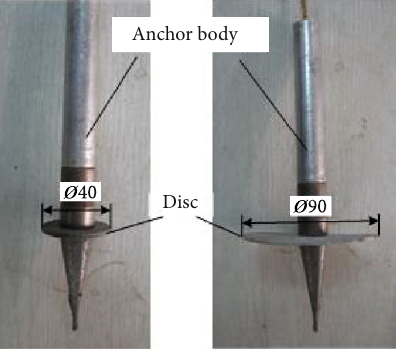
Figure 7: 40 mm and 90 mm diameter disc mounted on the anchor body.